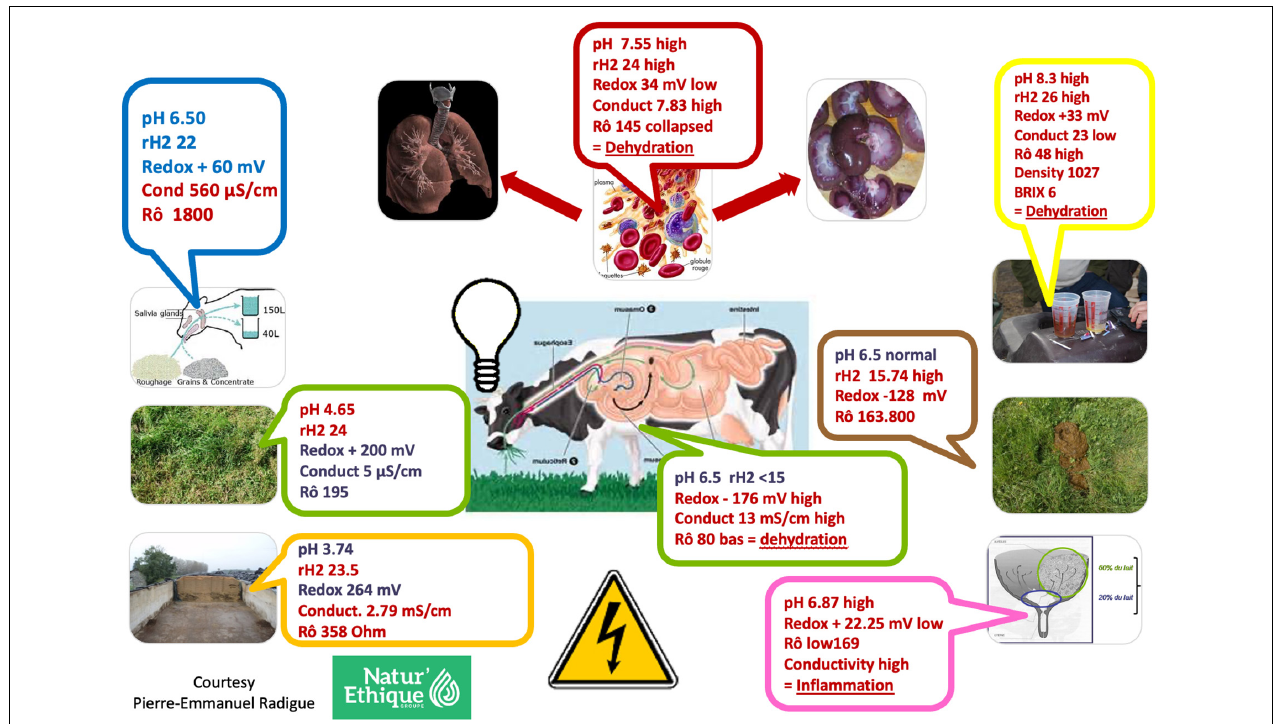
FIGURE 3 | Example of disorders analyzed by Eh-pH on soil, plant, and livestock.